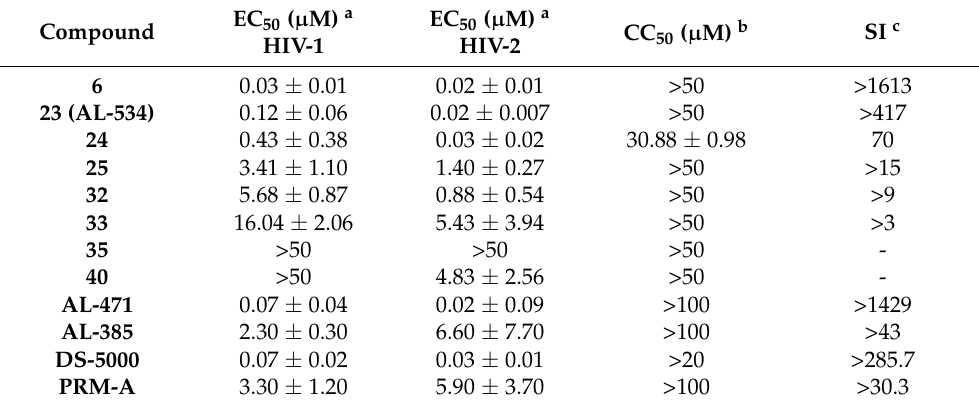
Table 1. Anti-HIV-1/HIV-2 activities of the synthesized